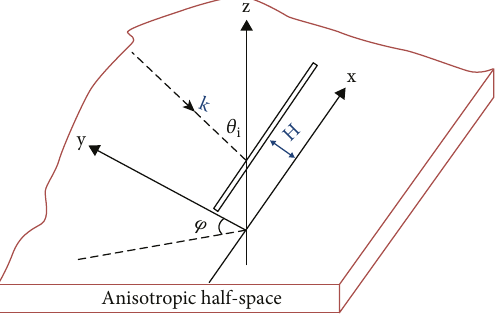
Figure 1: Thin wire over layered anisotropic half-space.